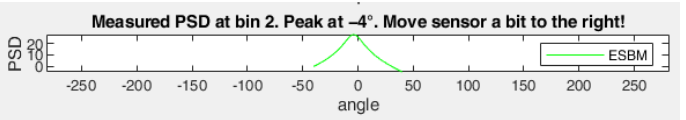
Figure 6. Example of returned PSD. Target detected at